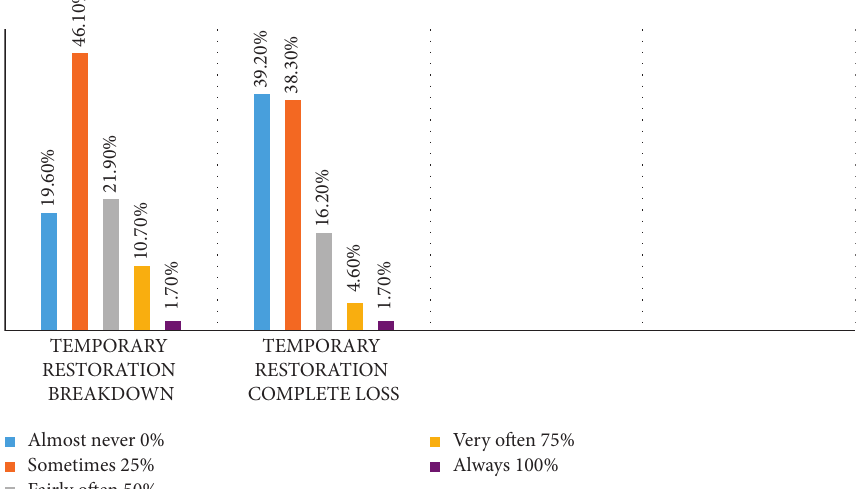
Figure 3: The frequency of clinically observing the deterioration or complete loss of access cavity temporary material in the